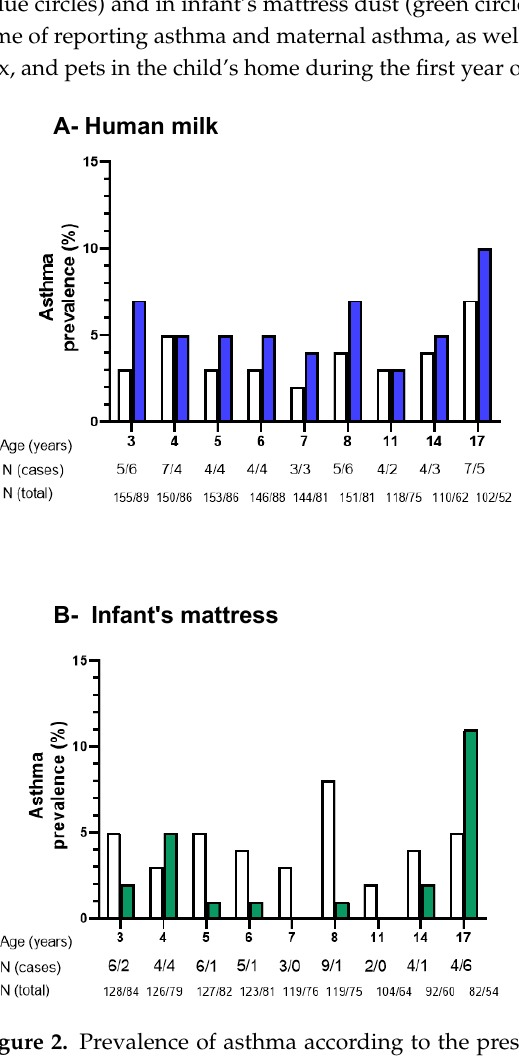
Figure 2. Prevalence of asthma according to the presence of Der p 1 in human milk and infant’s mattress. Prevalence of asthma in the past 12 months in 3–17-year-old children exposed to non- detectable (empty columns) and detectable (filled column) Der p 1 in human milk ( A ) and mattress dust ( B ). N represents the number of children with asthma symptom (cases) and the total population (total). Fisher’s exact test was used to compare the prevalence of asthma between groups.